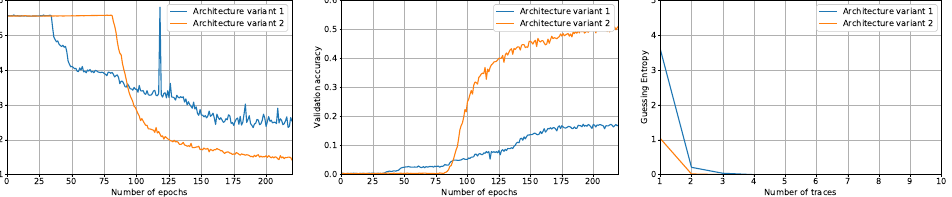
Figure 10: Results of synchronized AT128-N.